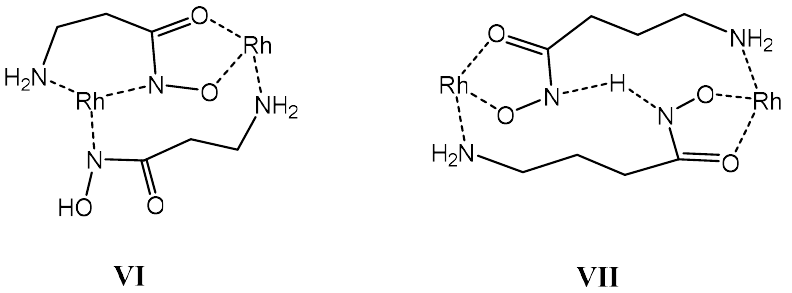
12 of 27 Figure 4. pH-dependence of the log K ’ conditional stability constants at 0.20 M KNO 3 for a model 5- membered and 6-membered (N,N) chelate (formed with en and pn, respectively), as well as for a 5- membered (O,O) (formed with aha − at 0.20 M KNO 3 or at 0.20 M KCl) and for a 5-membered (N amino ,O carb ) chelate (formed with GlyGlyAla − at 0.20 M KCl) in their interaction with [(η 5 -Cp*)Rh] 2+ . Black lines indicate logK’ values determined in KNO 3 , while grey lines, values obtained in KCl me- dium. Vertical line indicates pH = 7.4. In the case of the γ-Abha system, experimental data support the formation of the hydroxamate (O,O)-chelated species under acidic conditions and, since the 7-membered (N amino ,N hydr ) chelate has significantly lower stability than that of the (O,O) chelate, its con- curring effect is also smaller, resulting in the formation of much less of an amount of [M 2 H −1 L] 2+ than for the beta-derivative (as it is detailed in ref. [47]). It is also worth men- tioning that [M 2 H −1 L] 2+ is the only species that has an identical binding mode with all three of the aminohydroxamates. Based on the data in Table 3 for this type of complex, the de- creasing stability of the (N amino ,N hydr ) chelate with an increasing size is clearly reflected in the determined stability constants. A common feature of the organorhodium–β-Alaha – and –γ-Abha − equilibrium